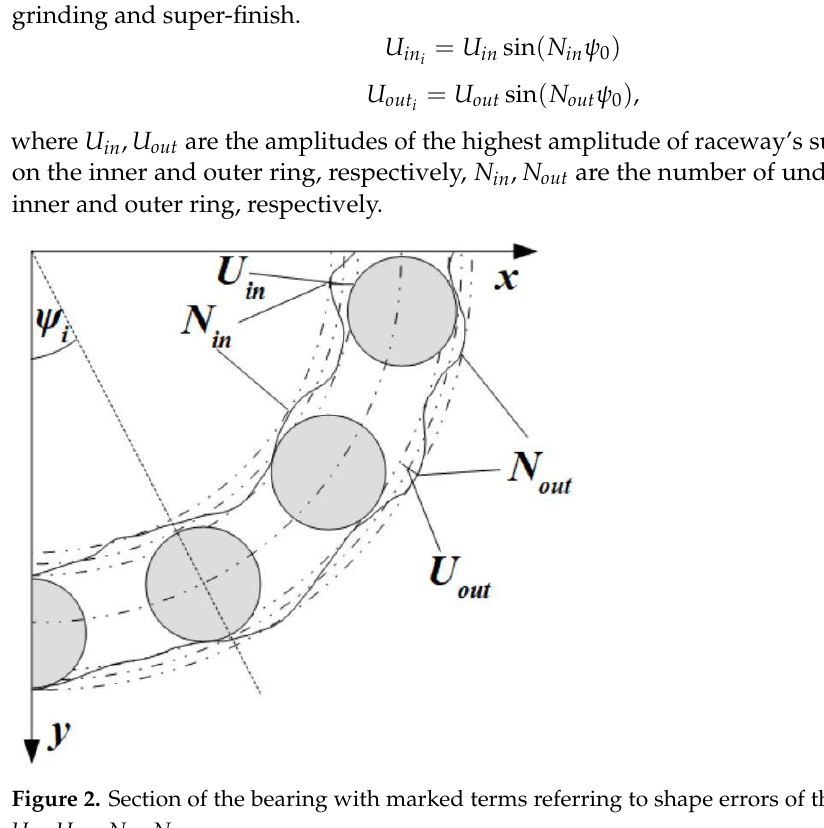
4 of 20 Figure 1. Scheme of the double-row self-aligning ball bearing mounted on the shaft. In the figure, the ball diameter D , pitch diameter d p , and β are marked. 2.2. Shape Errors